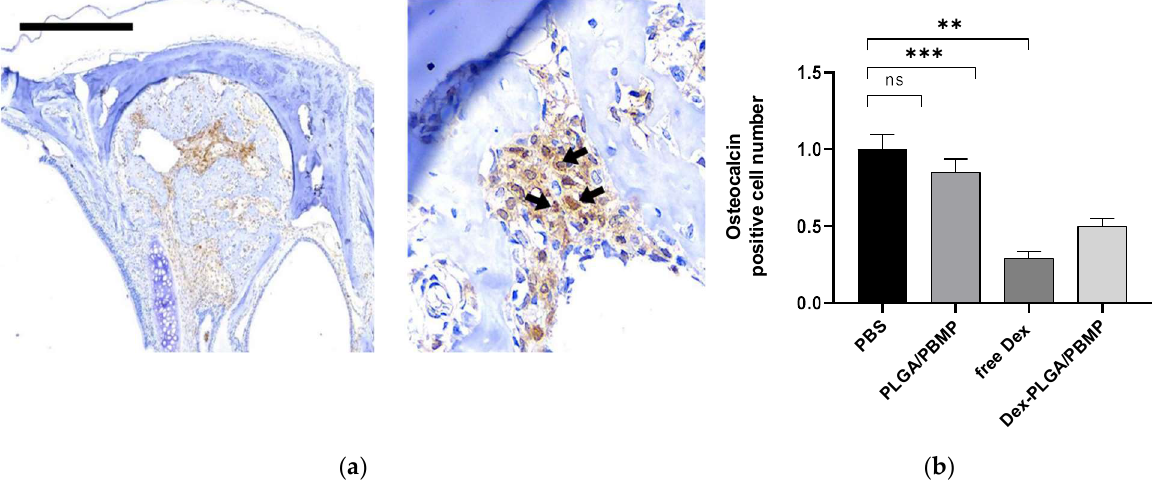
Figure 6. Comparison of osteocalcin activity in the IHC images of the sinonasal cavity treated with various formulations. ( a ) Representative antibody-stained images image showing the osteoblast- related bone regeneration in the mucosal defect area. The black arrows show the osteocalcin-positive cells. The scale bar represents 500 μm. ( b ) Relative osteocalcin activity. The relative numbers of osteocalcin-positive cells were compared. The bar indicates the mean ± SEM ( n = 7). The statistical analysis was performed using one-way ANOVA test. ** and *** indicate p < 0.01 and p < 0.001, respectively. ns means not significant.